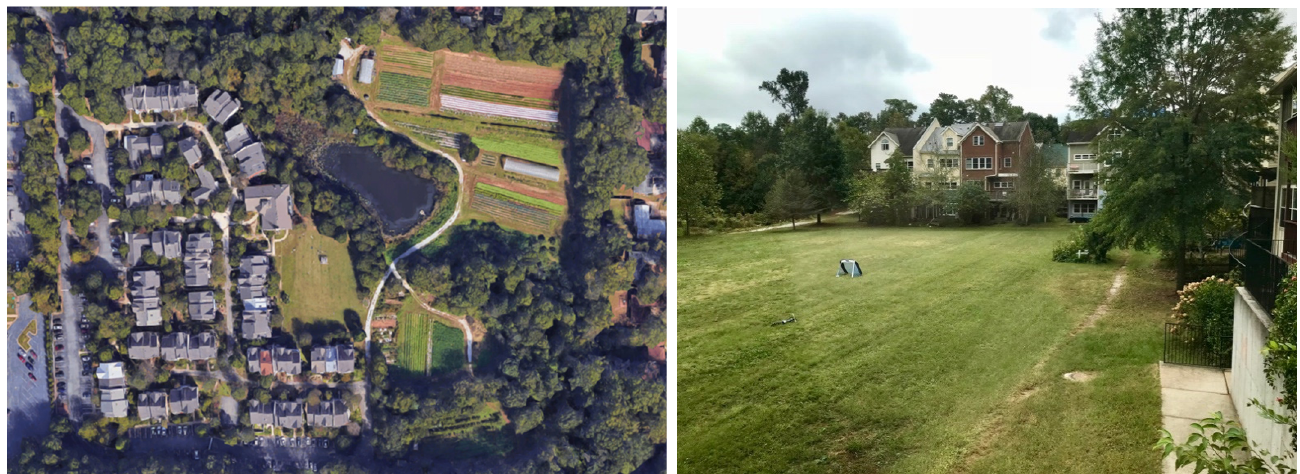
Figure 2. East Lake Commons, with organic farm Gaia Gardens, and a view of the open space next to the common house.